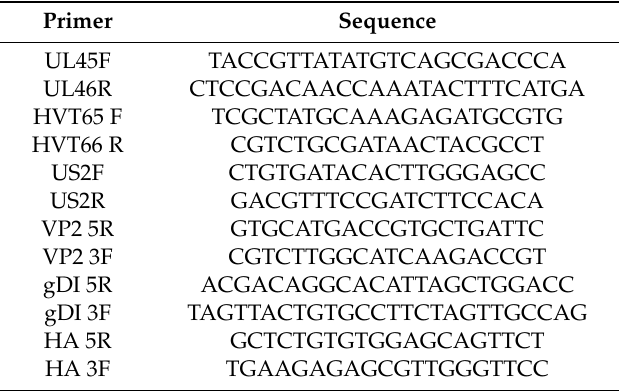
Table 3. Primers used for junction PCR and knock-in